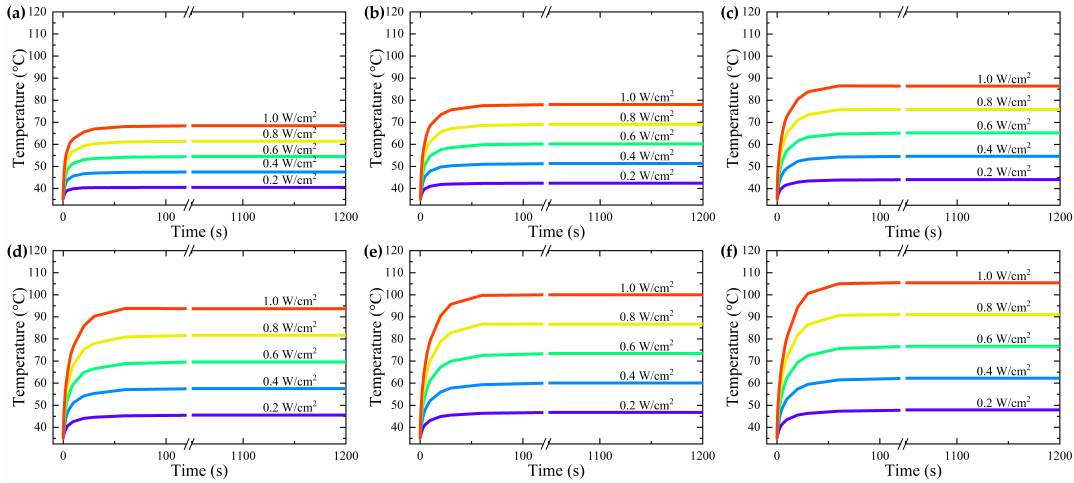
Figure 4. Time-dependent temperature evolution of at the top center of the cornea layer under different power densities (0.2 ∼ 1W/cm 2 as marked in the figure) and terahertz beam radius of ( a ) w 0 = 1.5mm; ( b ) w 0 = 2.0mm; ( c ) w 0 = 2.5mm; ( d ) w 0 = 3.0mm; ( e ) w 0 = 3.5mm; and ( f ) w 0 =